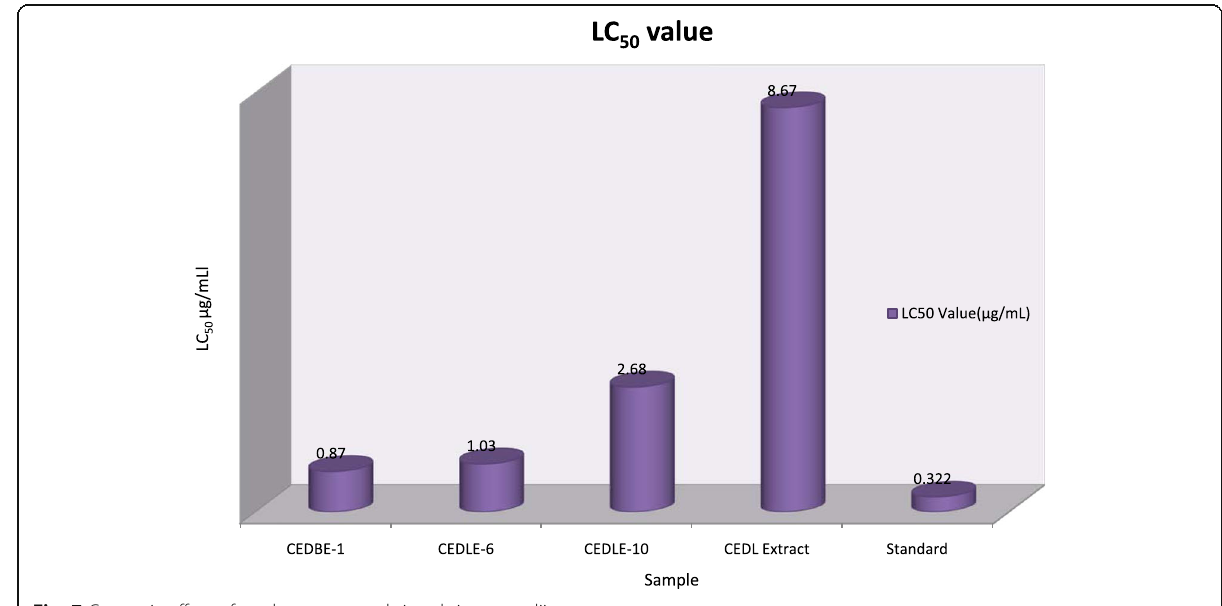
Fig. 7 Cytotoxic effect of crude extracts on brine shrimp